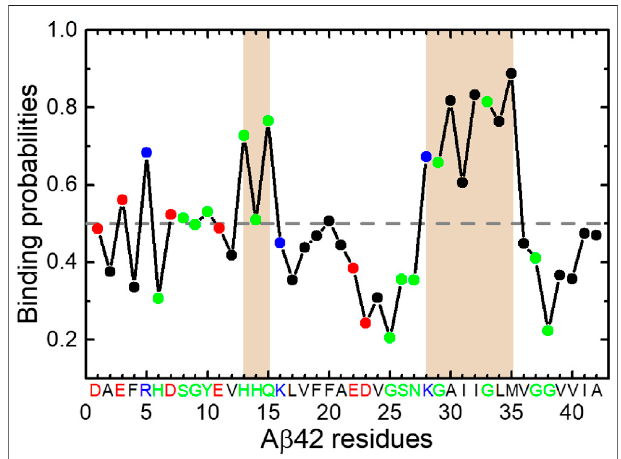
FIGURE5| BindingprobabilitiesofA β 42residueswithHSA.Datapoints are colored according to residue types (acidic: red; basic: blue; polar: green; hydrophobic: black). Regions displaying relatively high binding probabilities are highlighted by brown shading. The average binding probability is displayed as a horizontal dashed